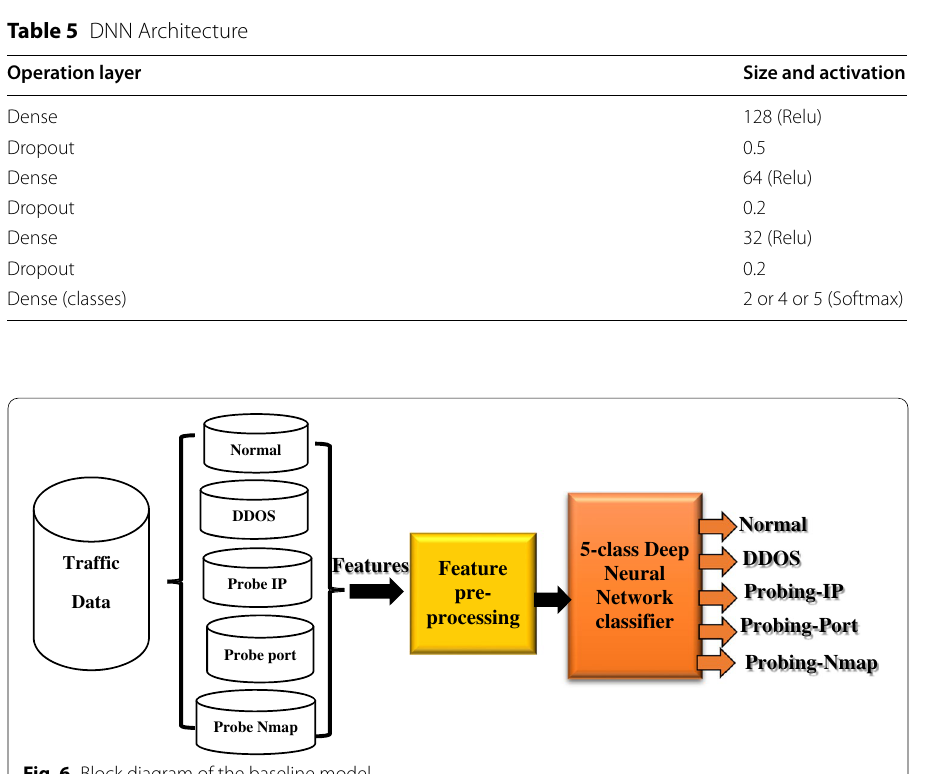
Fig. 6 Block diagram of the baseline